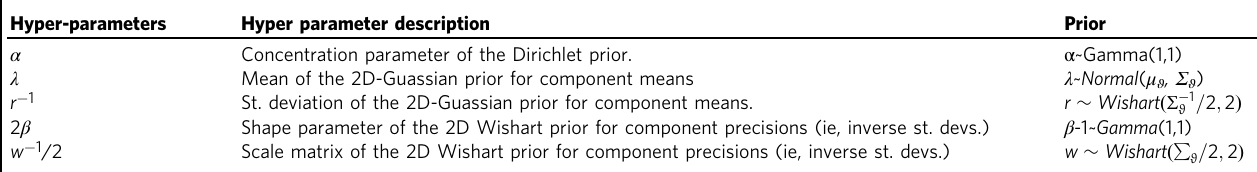
Table 1 Hyperparameters of the in fi nite Gaussian mixture model and the associated priors used in our analysis.